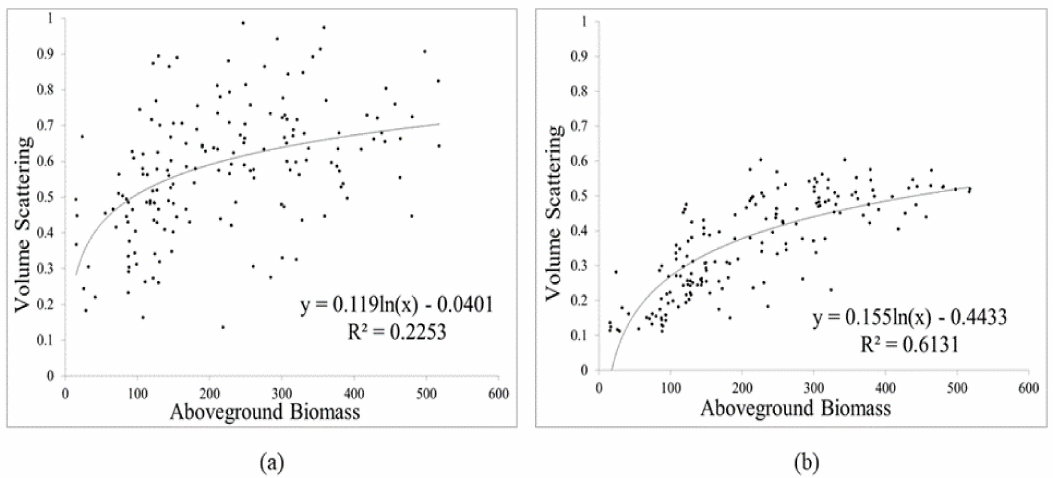
Figure 13. Regression between AGB and volume scattering obtained from: ( a ) PolSAR decomposition before deorientation of coherency matrix, and ( b ) PolSAR decomposition after deorientation of the coherency